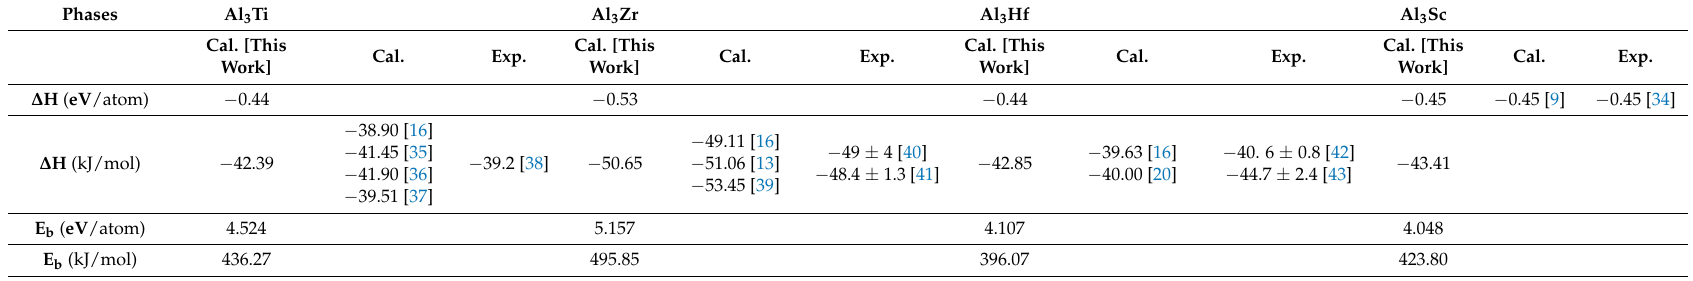
Table 2. Enthalpy of the Al 3 TM(TM = Ti, Zr, Hf, Sc) phases in the primitive units and the formation enthalpy and binding energy of the calculated